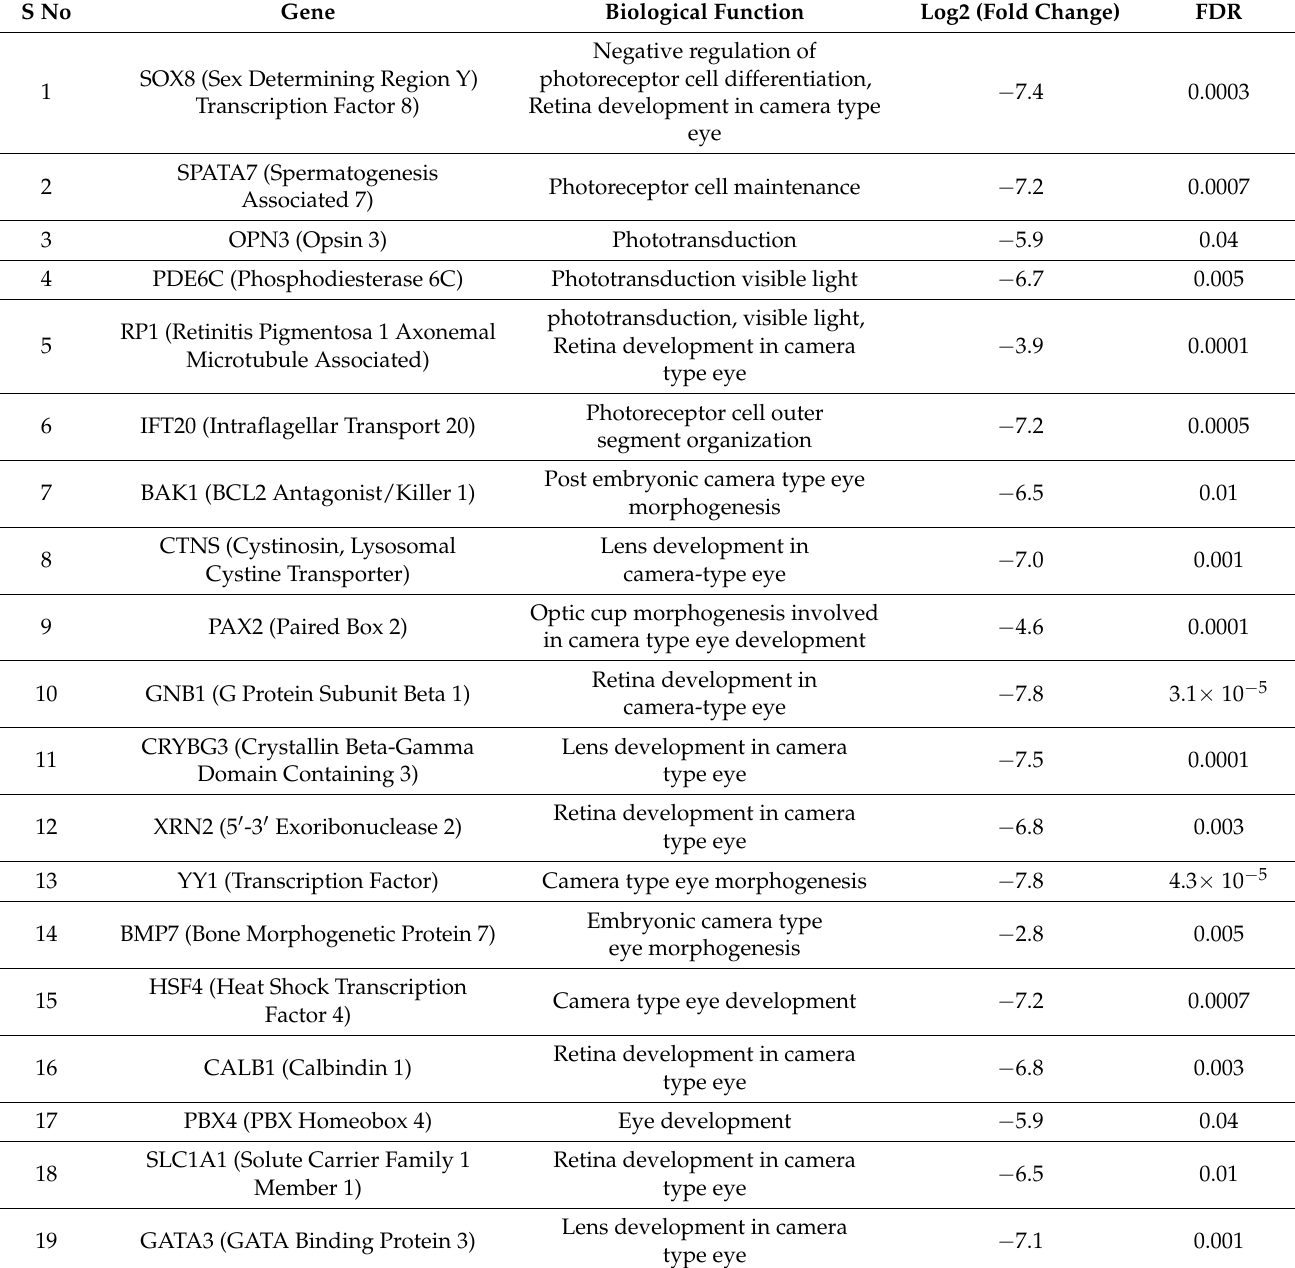
Table 2. Down regulated Retinoblastoma serum-derived small extracellular vesicles genes involved in ocular